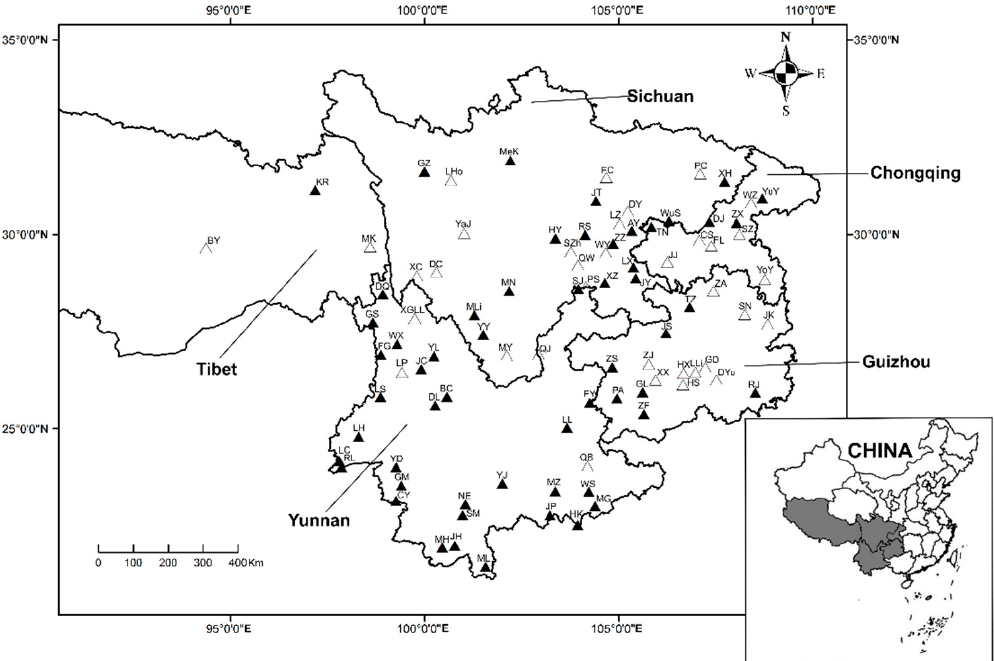
Figure 1. A total of 91 survey sites and sites where oriental house rats ( Rattus tanezumi ) were sampled in 5 provincial regions of Southwest China between 2001 and 2019 (symbols: filled black triangles represent sites where R. tanezumi were captured and hollow triangles represent sites without R. tanezumi captured).